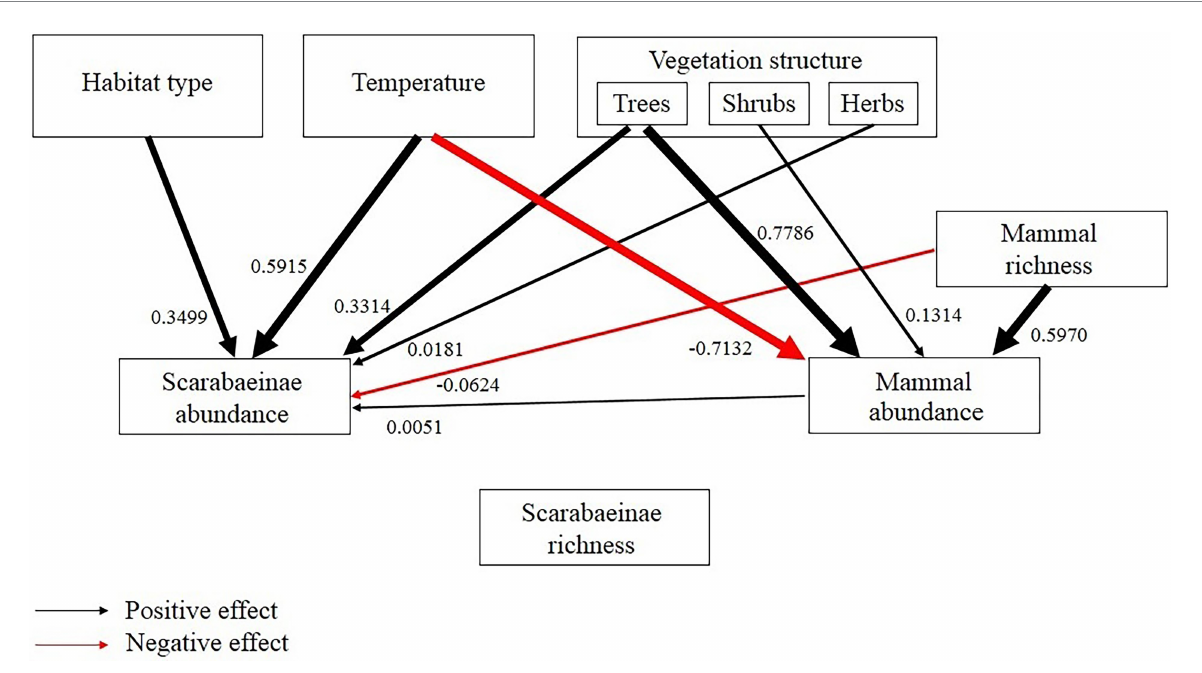
FIGURE 6 Structural equation model for dung beetle richness and abundance. The arrows indicate the significant influence of environmental factors and resources (with their respective coefficients) on dung beetle abundance. Black arrows denote positive relationships, and red arrows denote negative